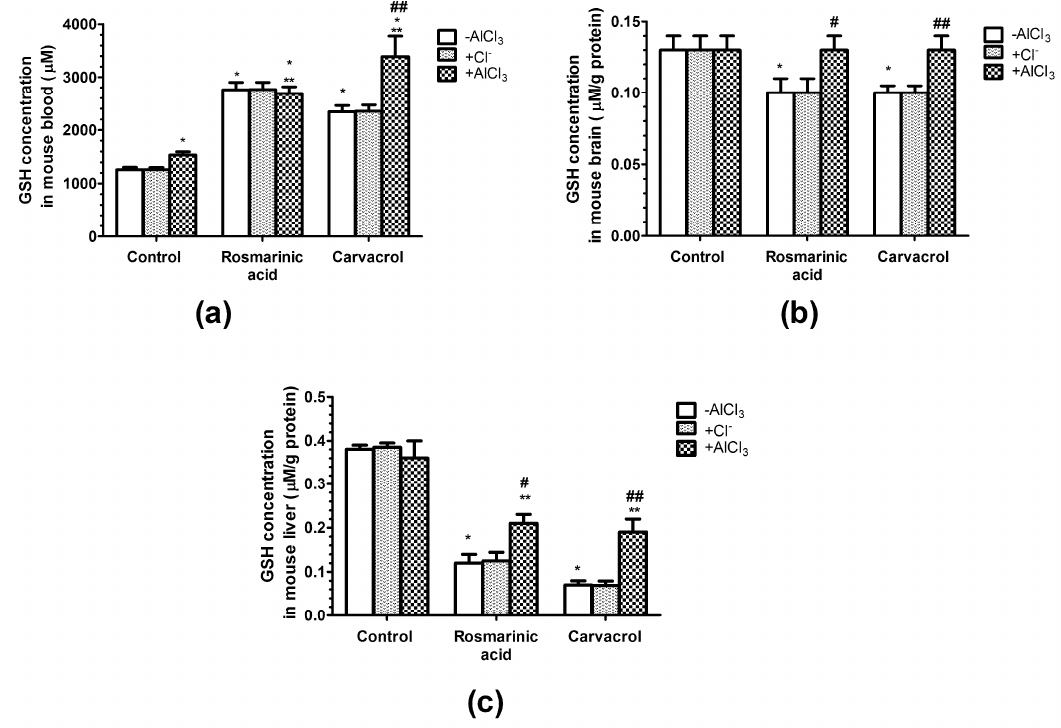
Figure 2. Influence of aluminum ions, rosmarinc acid, and carvacrol on the concentration of glutathione (GSH) in mice erythrocytes ( a ) and brain ( b ) or liver ( c ) homogenates. ( n = 9, * p < 0.001 vs. control, ** p < 0.001 vs. AlCl 3 , # p < 0.01 vs. rosmarinic acid in the absence of AlCl 3 , ## p < 0.01 vs. carvacrol in the absence of AlCl 3 ).